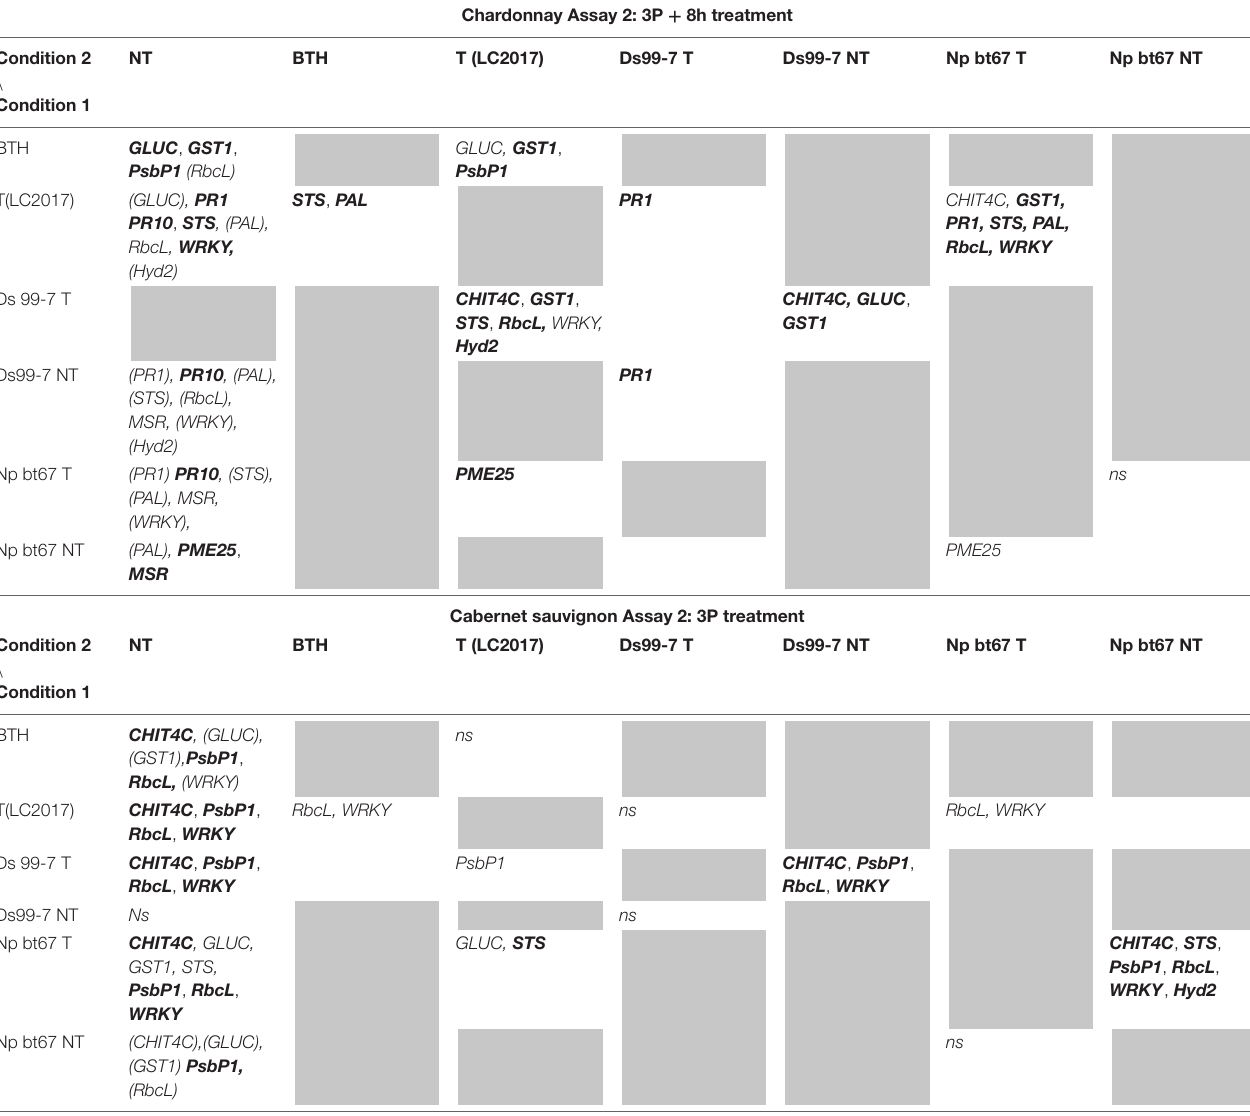
TABLE 2 | Results of the statistical analysis (Mann-Whitney U test) on Assay 1 transcriptomic data recorded in vines “Chardonnay” (upper part) and “Cabernet sauvignon” (lower part) at 3P + 8 h: the reported genes resulted with both relative expression > 2 and significantly induced for p < 0.05 (in bold those significant for p < 0.01) in condition 1 when compared to the other conditions (condition